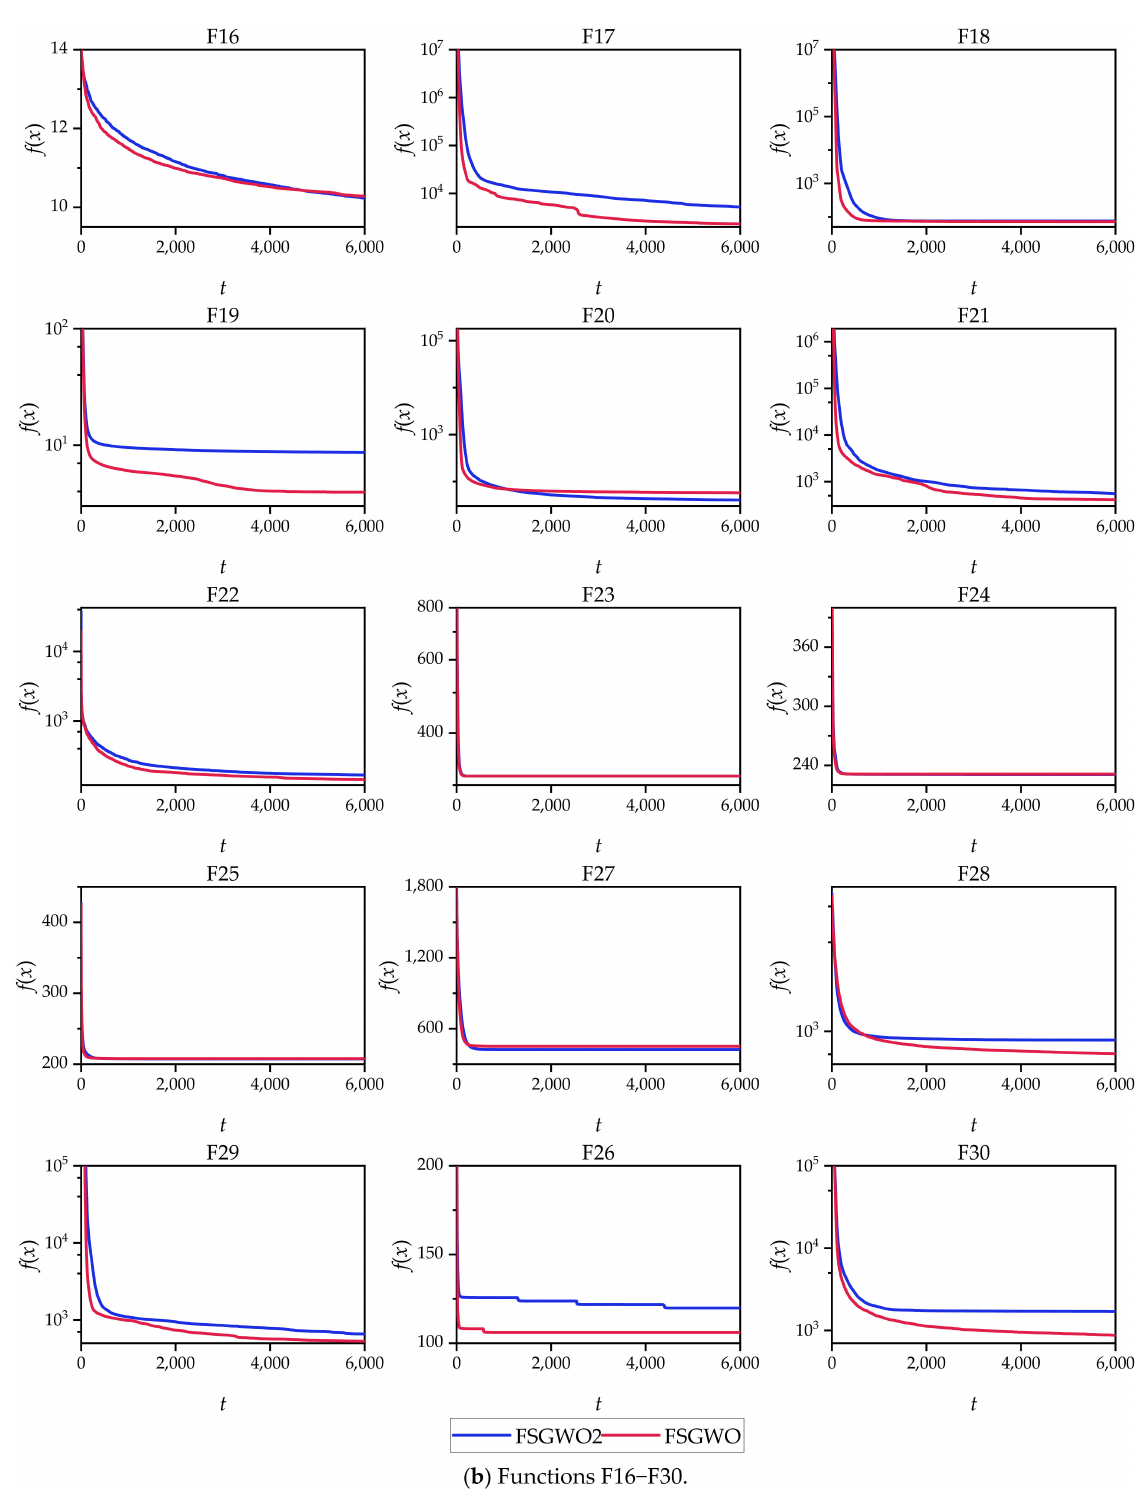
Figure 6. Convergence curves for FSGWO and